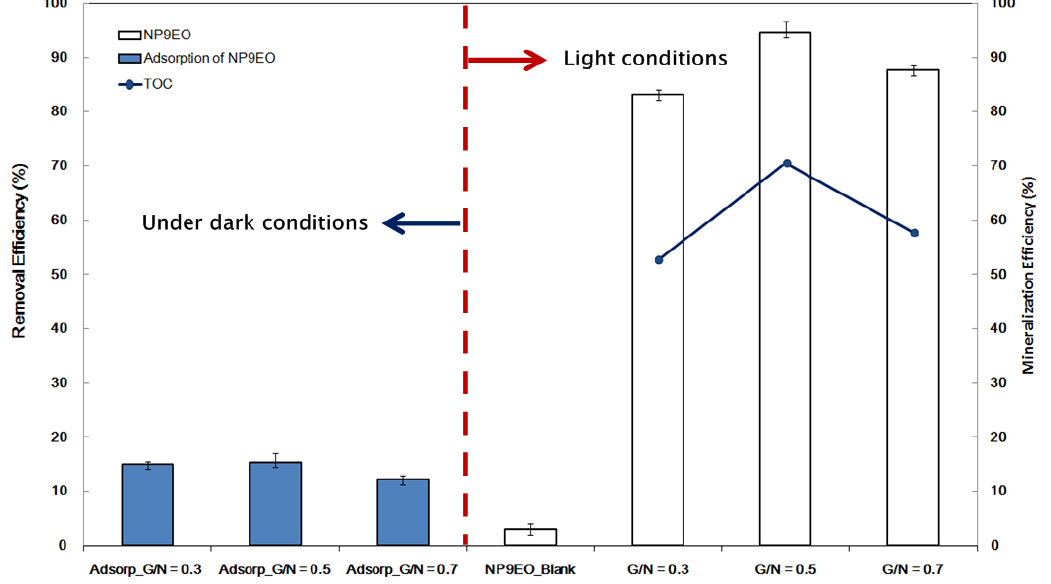
Figure 7. NP9EO degradation curves for Cu-based catalysts synthesized at different G/N ratios. Data presented are the average of duplicate experiments with relative standard deviation. (Catalyst dosage = 0.3g/L, NP9EO = 100 mg/L, H 2 O 2 = 0.05 mM (1000 mg/L), pH = 6.)